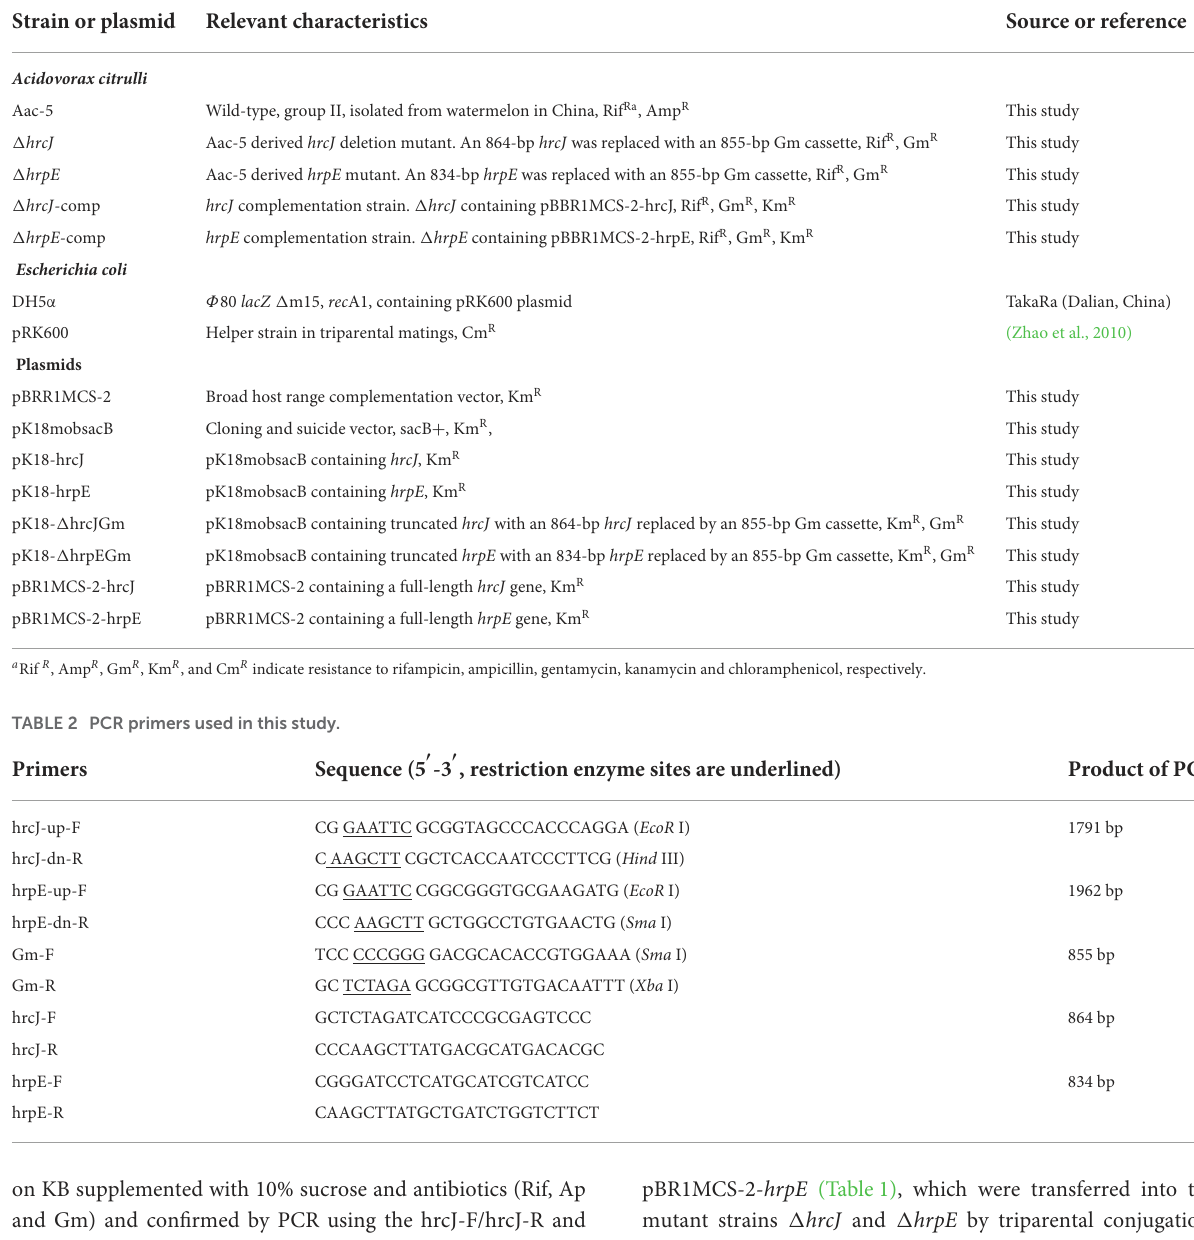
TABLE 1 Strains and plasmids used in this study.